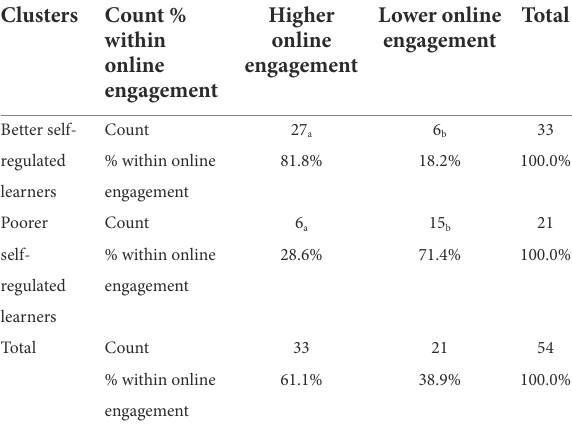
Higher Lower online online engagement engagement